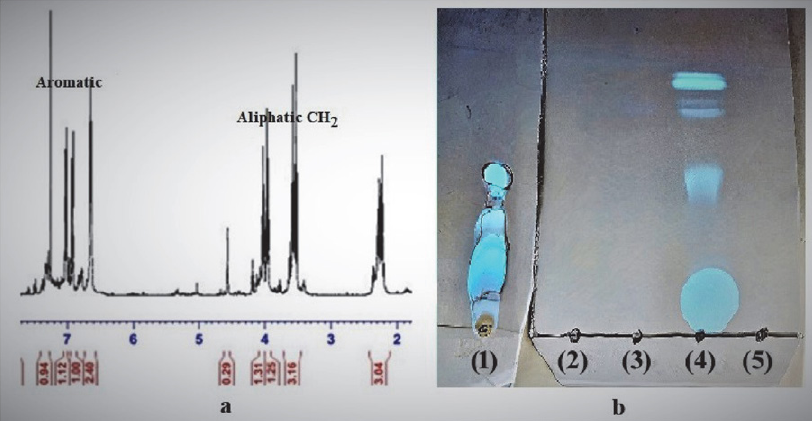
Figure 2.a. HNMR analysis of chemosensor 3; b. (1) The appearance of fluorescence BSP-3 (2) DMF, (3) Chloroform, (4) Acetone and (5) H 2 O under UV light on